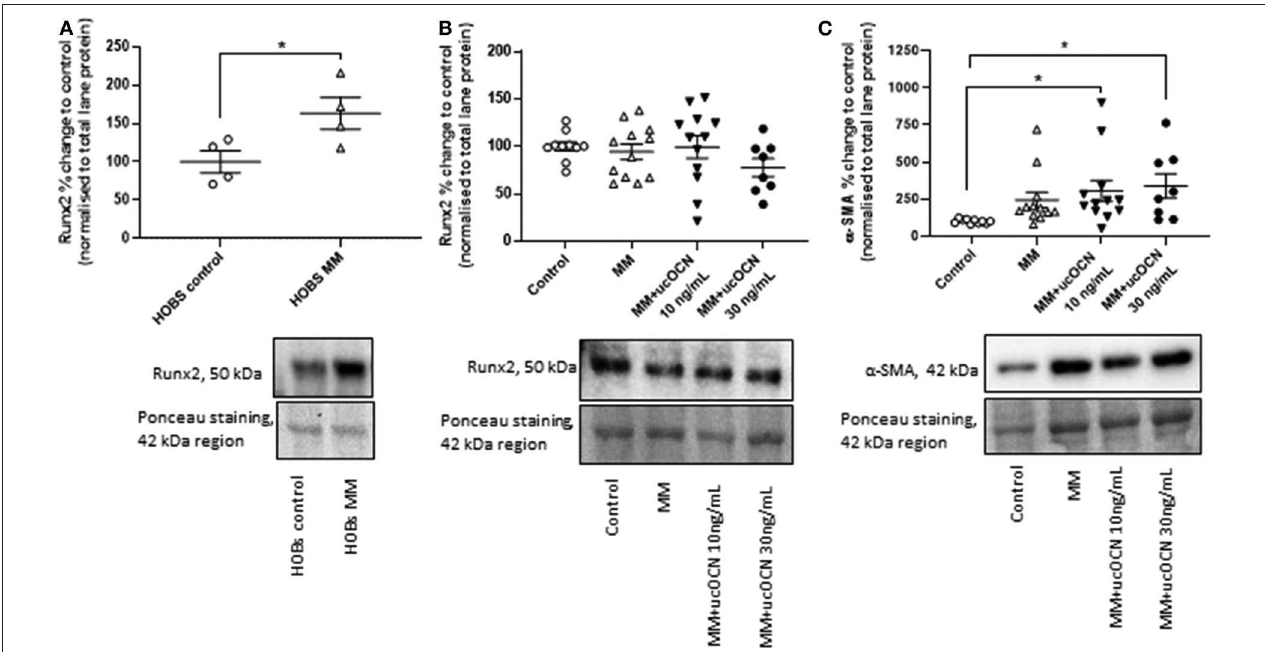
FIGURE 5 | Human aortic smooth muscle cells (SMCs) were cultured in usual growth media (control), or mineralisation media (MM) with or without ucOCN (10 or 30ng/mL). (A) Human osteoblasts (HOBs) were also cultured in control or MM and Runx2 expression was measured by western blotting. Expression of Runx2 (B) and α -SMA (C) in SMCs were measured by western blotting on day 21. Data are presented as means with error bars representing SEM. Data were analyzed by one-way ANOVAs or t-tests with * p <